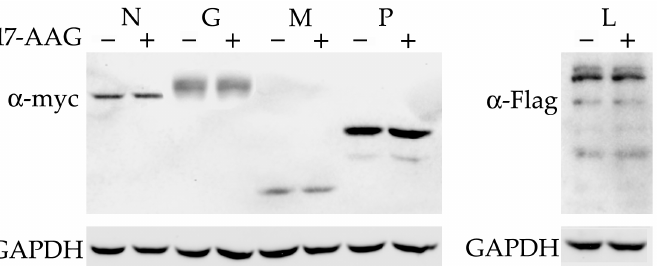
Figure 2. Hsp90 inhibition does not influence the expression of RABV proteins. HEK293 cells were transfected with plasmids expressing myc-tagged N, G, M, and P ( left panel) and Flag-L ( right panel). We added 500 nM 17-AAG 2 h after transfection. Expression was tested using anti-myc and anti-Flag antibodies 24 h later. The experiment was repeated twice, with similar results.